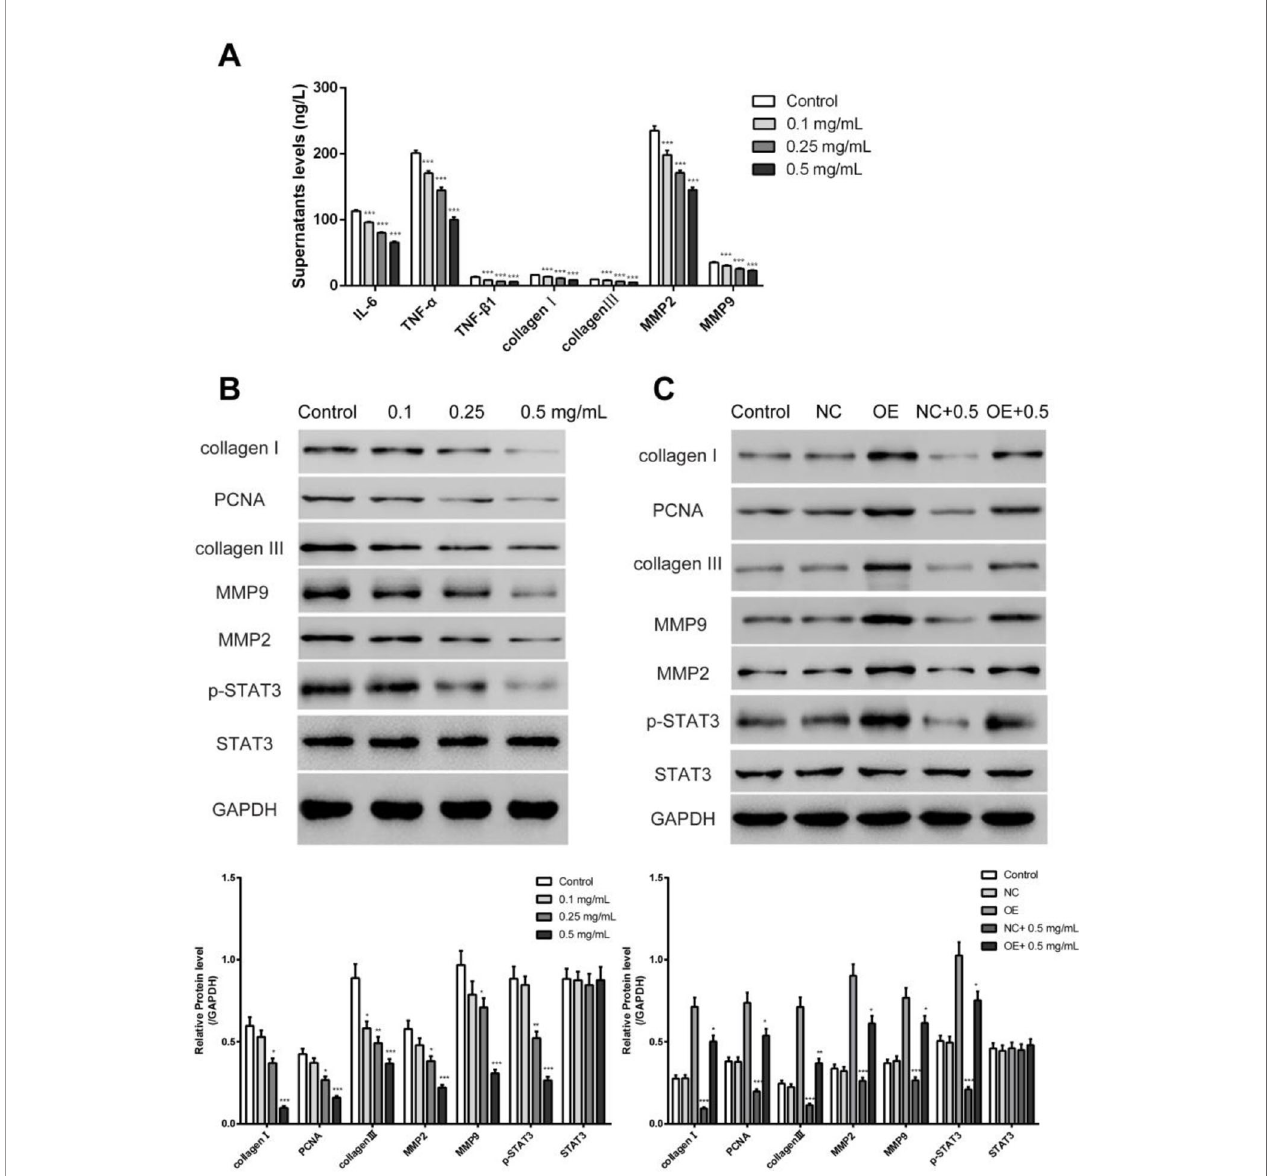
FIGURE 5 | EHF reduced the levels of in fl ammation and fi brosis related cytokines in NRK-49F cells. (A , B) The levels of in fl ammation and fi brosis related cytokines were examined by ELISA and Western blotting. (C) The protein levels of key related cytokines in the control group, negative control (NC), CXCL6 overexpression group (OE), NC+0.5 mg/ml EHF (NC+0.5) and OE+0.5 mg/ml (OE+0.5) were determined by Western blotting. *p < 0.05, **p < 0.01, ***p < 0.001 versus the control